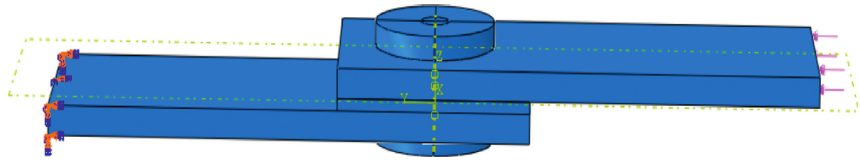
Figure 2: Numerical experiment of bolted structure compression test. Table 1: Material properties of the structure components.